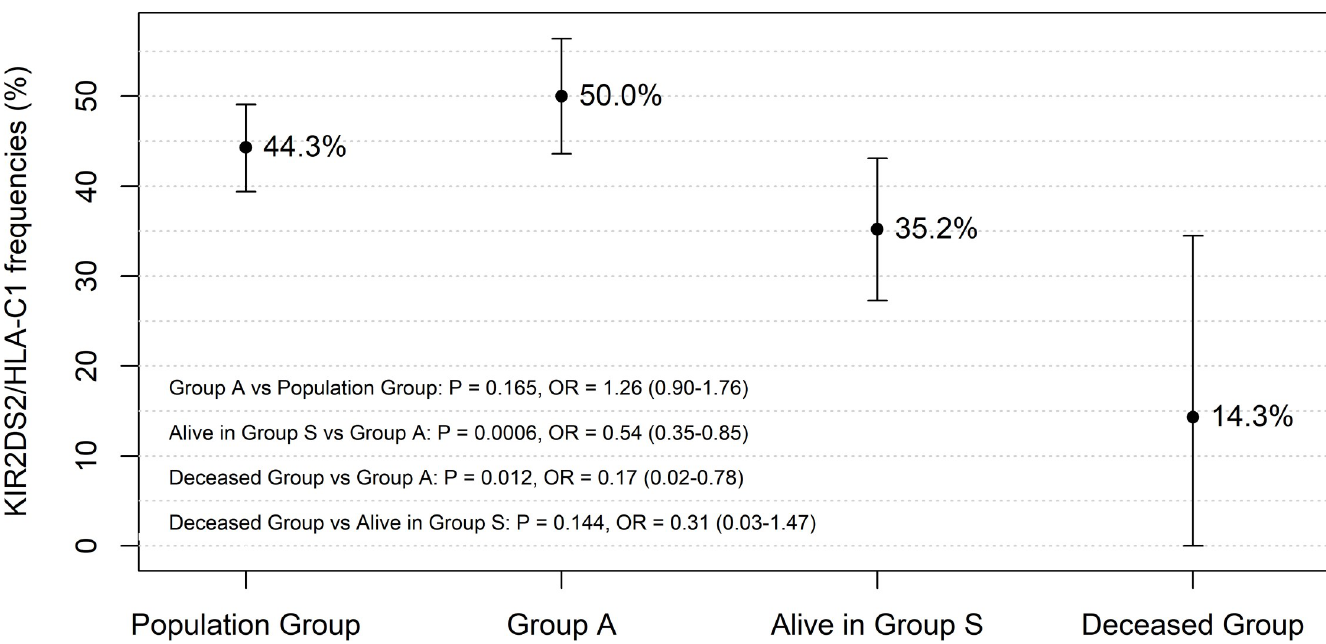
Fig 1. Frequency of the KIR2DS2 / HLA C1 functional unit compared between patients stratified according to the severity of COVID-19 clinical manifestations [Group A (N = 120/240, 50.0%), alive in Group S (N = 50/142, 35.2%) and deceased patients in group S (N = 2/14, 14.3%)]. The comparison between Group A (N = 120/240, 50.0%) and the population group (N = 177/400, 44.3%) showed a similar frequency in the two groups. The error bars represent the 95% confidence intervals of the KIR2DS2 / HLA C1 frequency in each group of patients and the population group.